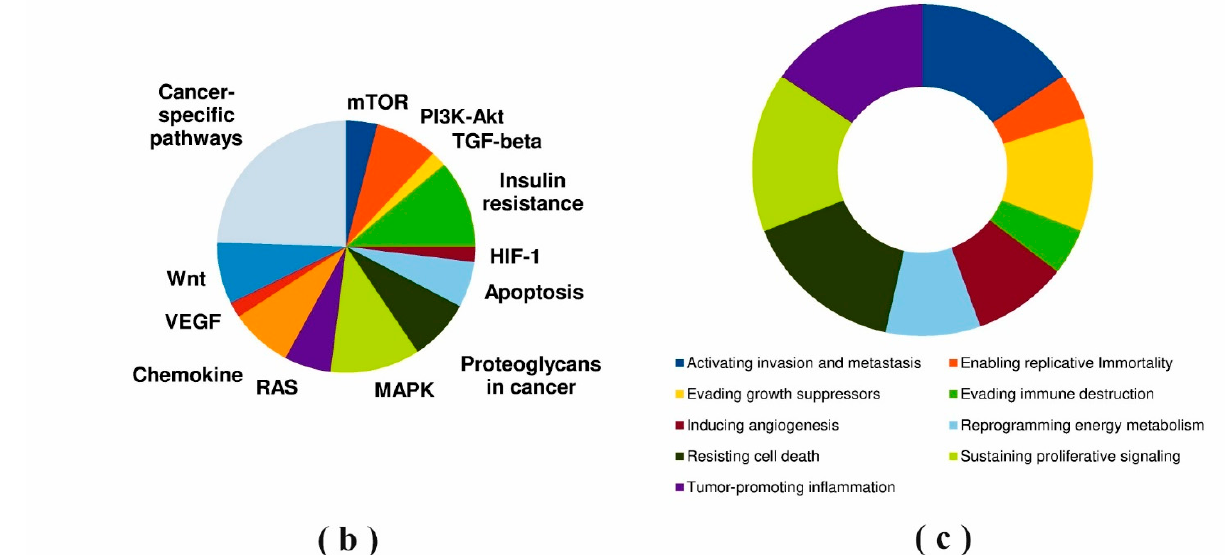
Figure 5. Annotation of modifying protein partners of target enzymes: distribution of functional classes ( a ); involvement in cancer pathways ( b ); enrichment with cancer hallmarks terms ( c ).